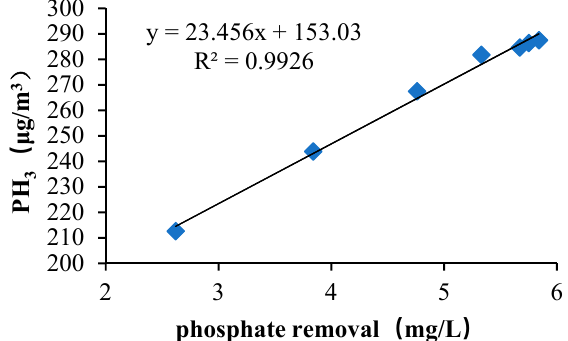
y = 23.456x + 153.03 R² = 0.9926 Figure 3. The correlation between the phosphate reduction and the phosphine production.